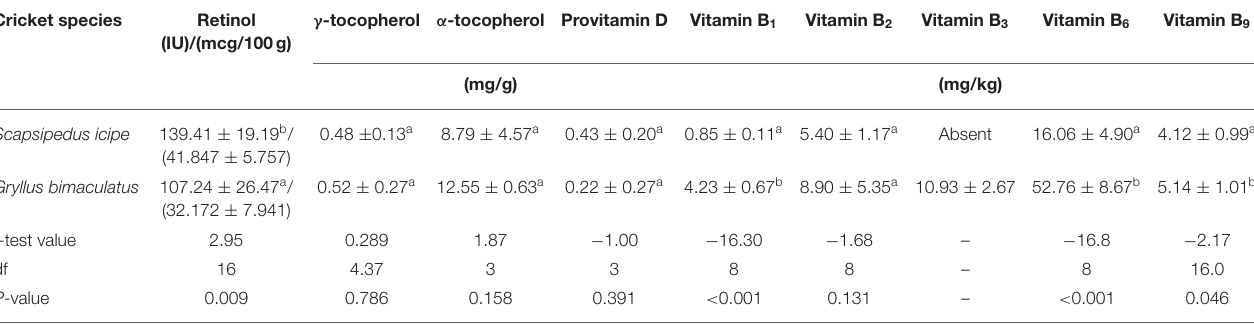
TABLE 4 | Vitamin composition of edible cricket species ( Scapsipedus icipe and Gryllus bimaculatus ) on dry matter basis (mean ± SE). Cricket species